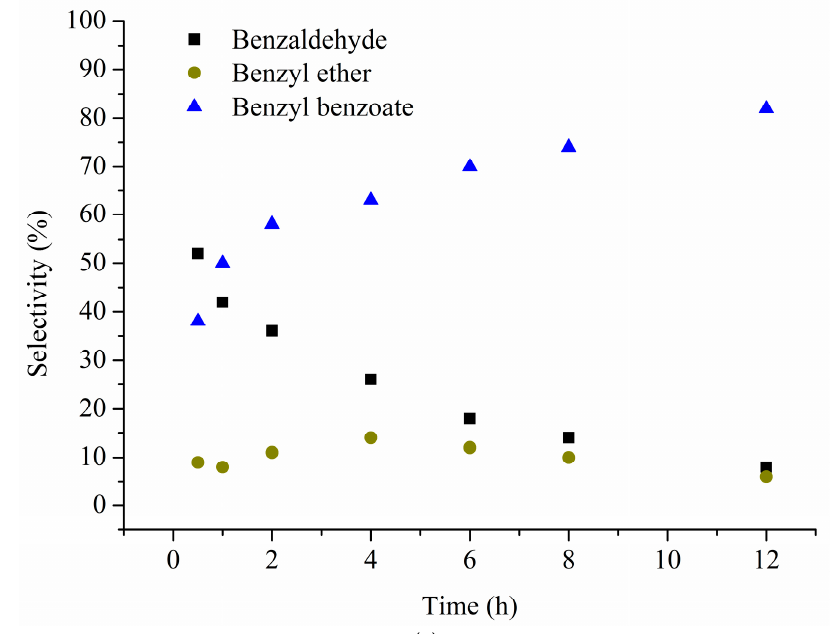
Figure 1. Reaction profile of un-promoted and promoted VPO catalysts with Au in the benzyl alcohol oxidation.